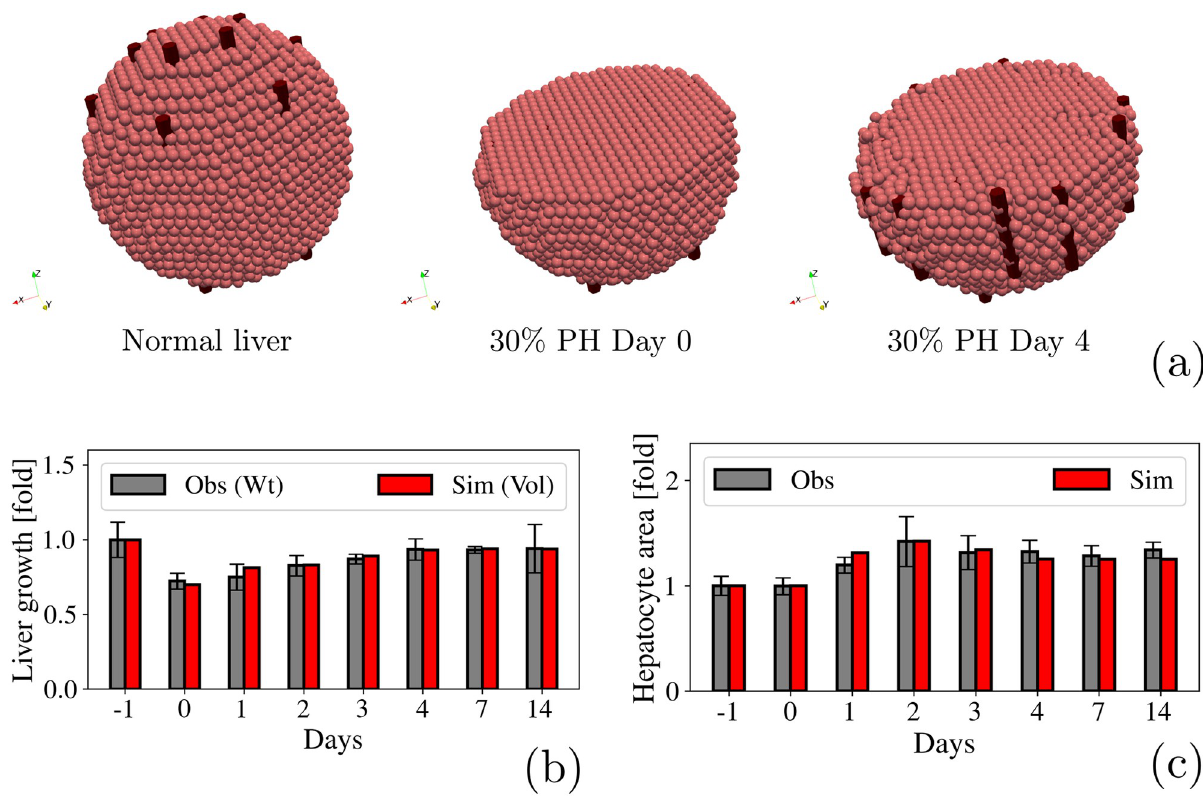
Fig 5. 30% PH. (a) Qualitative representation of the liver regeneration process after a 30% PH. (b) Fold-increase in the liver size. Observational data is shown in gray and represents the weight of the liver measured by Miyaoka et. al [44, 45]. Simulated data is shown in red and represents the liver volume. (c) Quantification of the hepatocytes area during liver